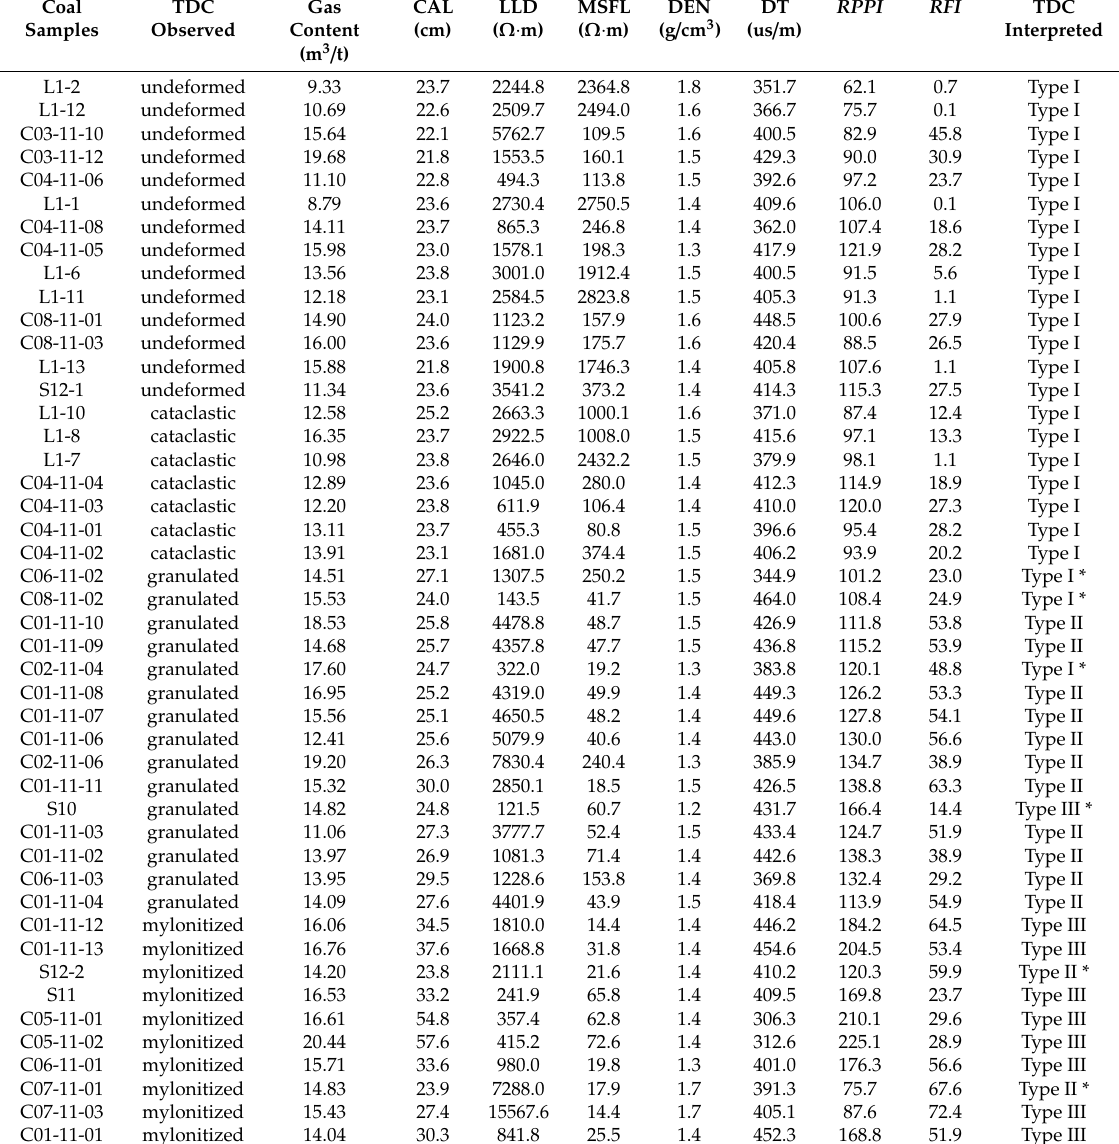
Table 4. TDC and logging data of coal core samples from the No. 11 coal in the HC